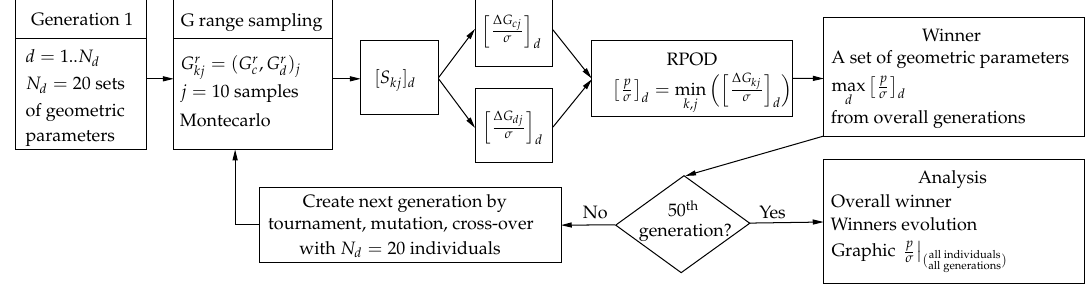
Figure 7. Optimization process maximizing RPOD with the genetic algorithm.